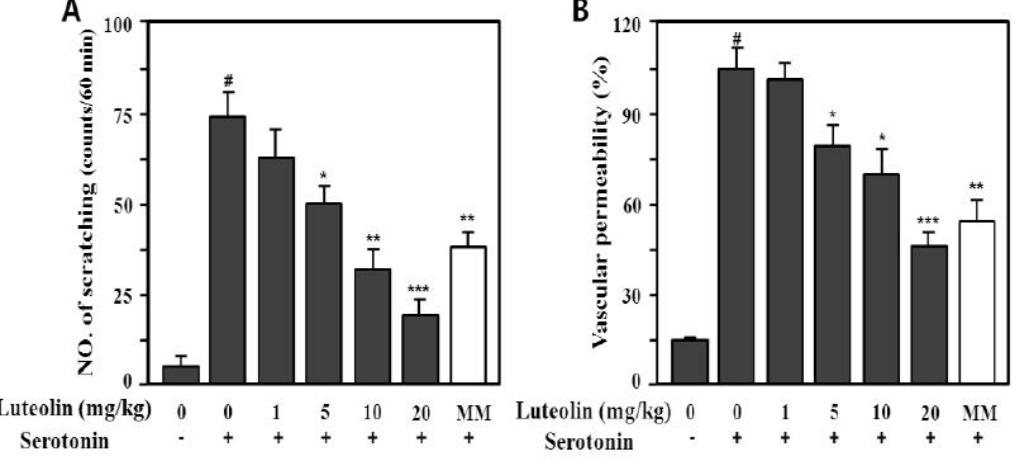
Figure 6. Effect of luteolin on serotonin-induced scratching behavior ( A ) and vascular permeability ( B ) in ICR mice. Scratching behavior was counted for 60 min after intradermal injection of serotonin (100 μ g/site). Luteolin (1–20 mg/kg) was administered orally 1 h before serotonin injection. Values are means ± SE ( n = 8). # p < 0.001 versus the non-treated control group; * p < 0.05, ** p < 0.05, *** p < 0.01 versus serotonin alone